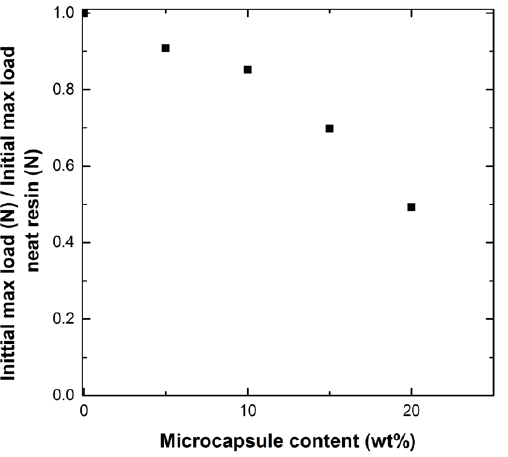
Figure 6. Initial maximum load of fracture (N) of virgin fracture toughness samples (Day 0) normalized to the initial maximum load value (N) of sample of neat resin for specimen with varying microcapsule content (wt%).